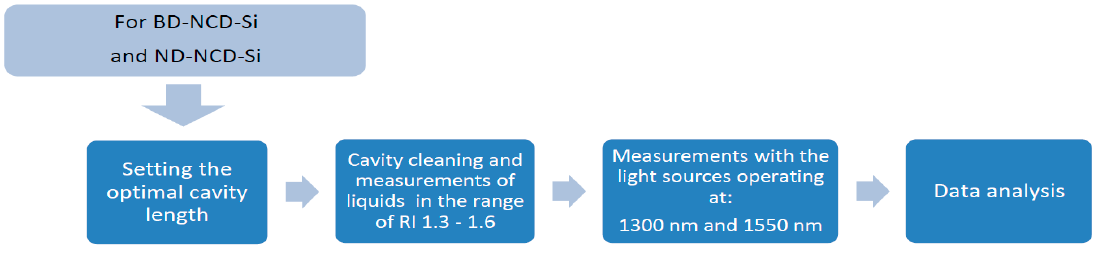
Figure 2. The block diagram of the experiment.